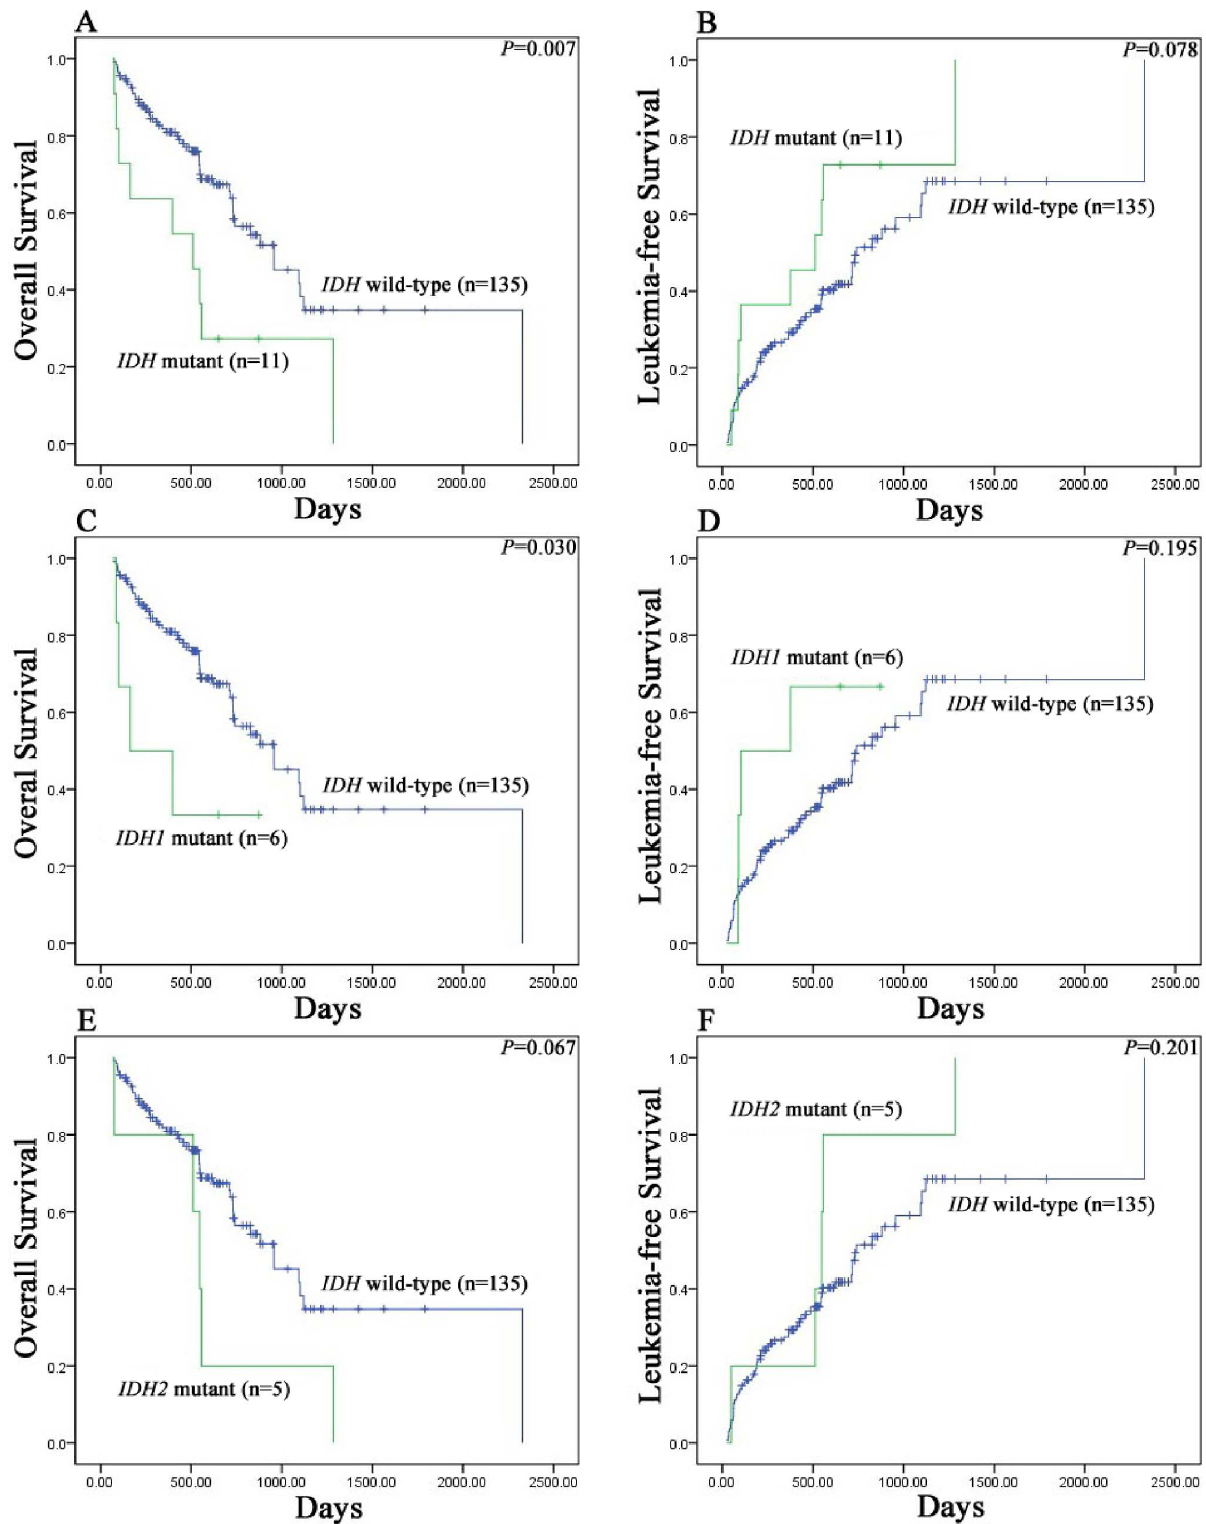
Figure 2. Kaplan–Meier survival curves for survival of MDS patients. (A) Overall survival data for MDS patients stratified by IDH1/2 mutational status. (B) Leukemia-free survival data for MDS patients stratified by IDH1/2 mutational status. (C) Overall survival data for MDS patients stratified by IDH1 mutational status. (D) Leukemia-free survival data for MDS patients stratified by IDH1 mutational status. (E) Overall survival data for MDS patients stratified by IDH2 mutational status. (F) Leukemia-free survival data for MDS patients stratified by IDH2 mutational status.